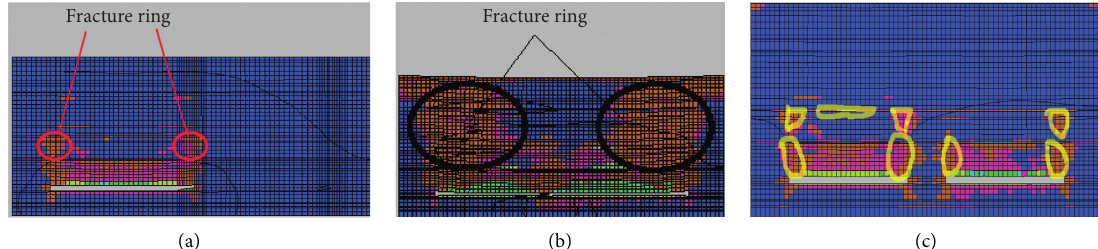
Figure 14: Numerical modelling of Vertical fractures development: (a)after extraction of the first SLL panel; (b)after extraction of two SLL panels; (c)after extraction of two CLL panels.